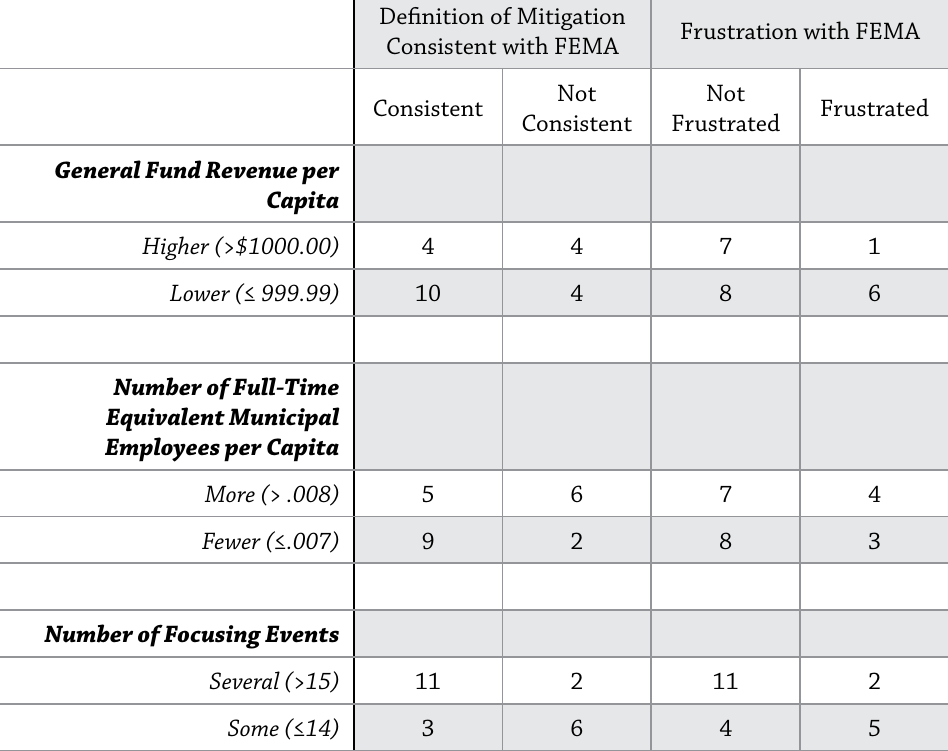
Table 7: Understanding of Mitigation and Frustration with FEMA by Community Charac- teristics General Fund Revenue